Question: What visual encoding does this figure use to show its data?
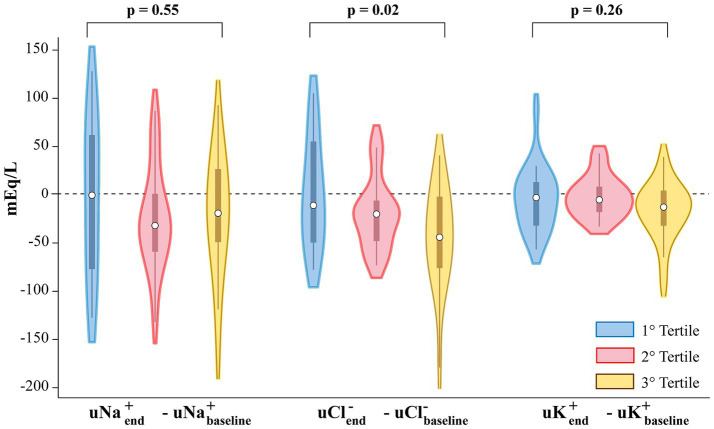
Answer: box